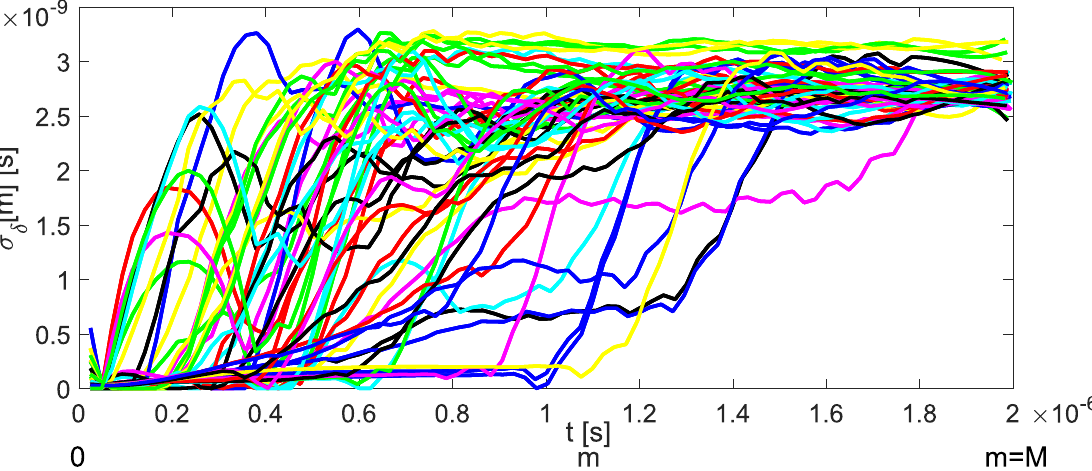
Figure 6. Standard deviation of δ as a function of time ( m ) for 50 different instances of circuit model ( K =